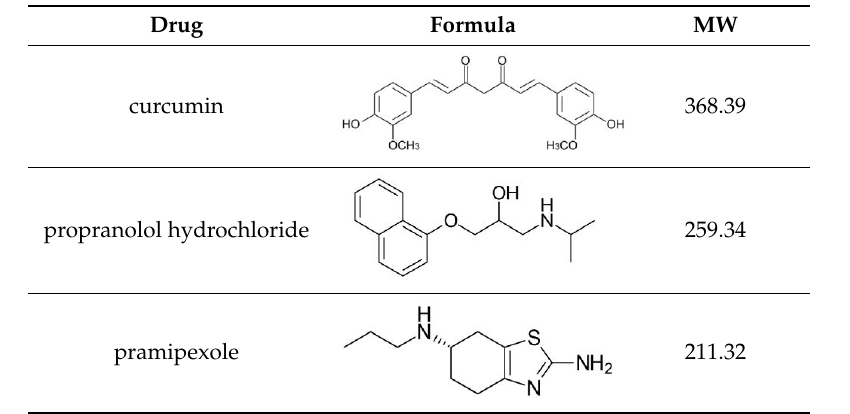
Table 1. Model drugs encapsulated in silk fibroin